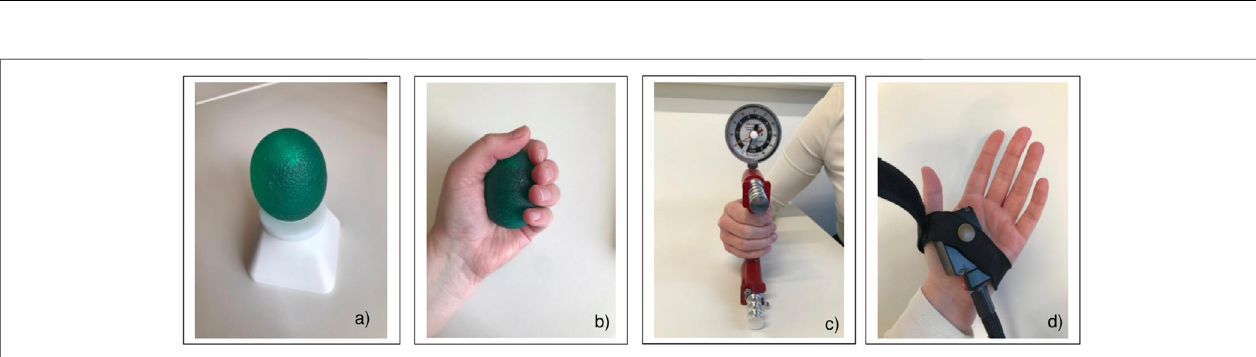
Frontiers in Physiology |